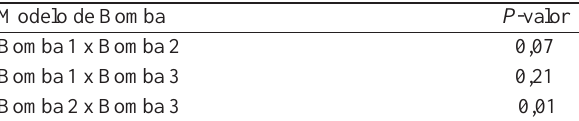
Tabela 2. Comparação de variâncias dos perfis de velocidade de queda (n=7) para os três modelos de bombas.